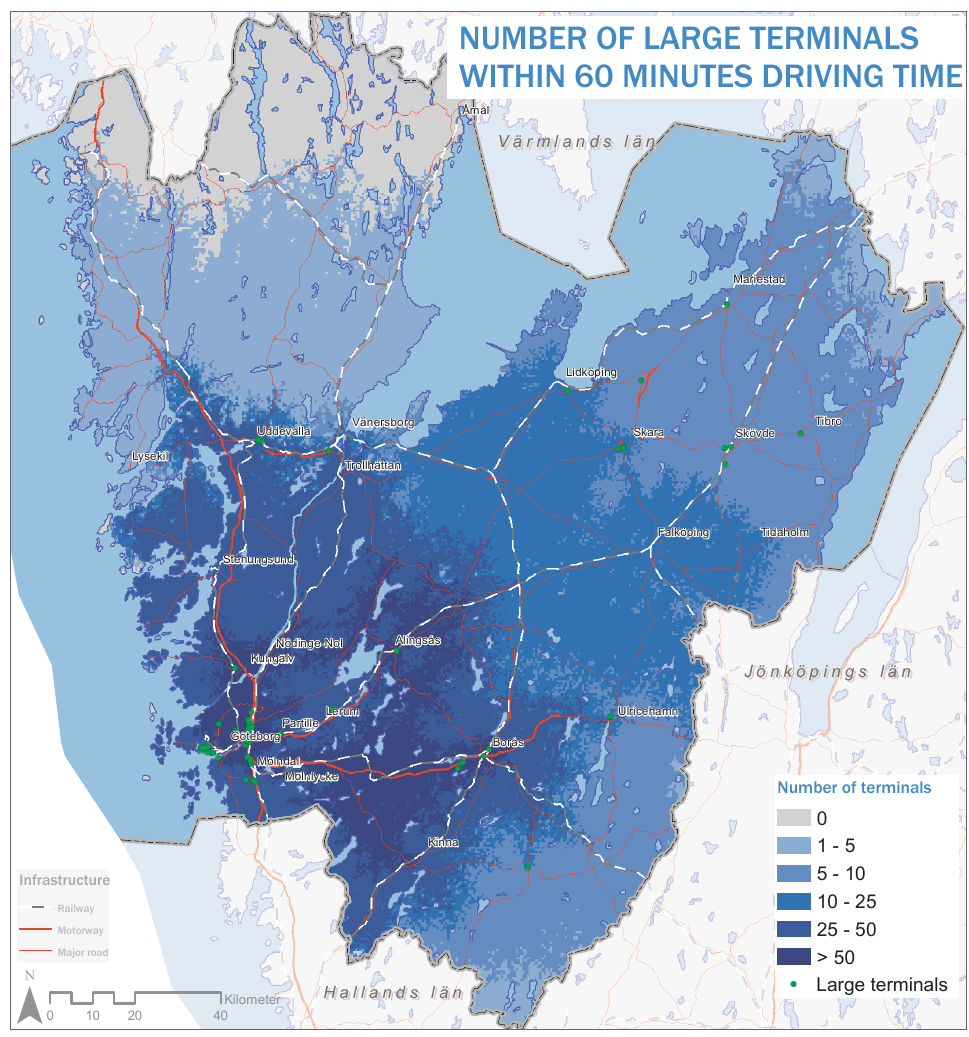
Figure 6: Number of large terminals accessible within 60 minutes of driving